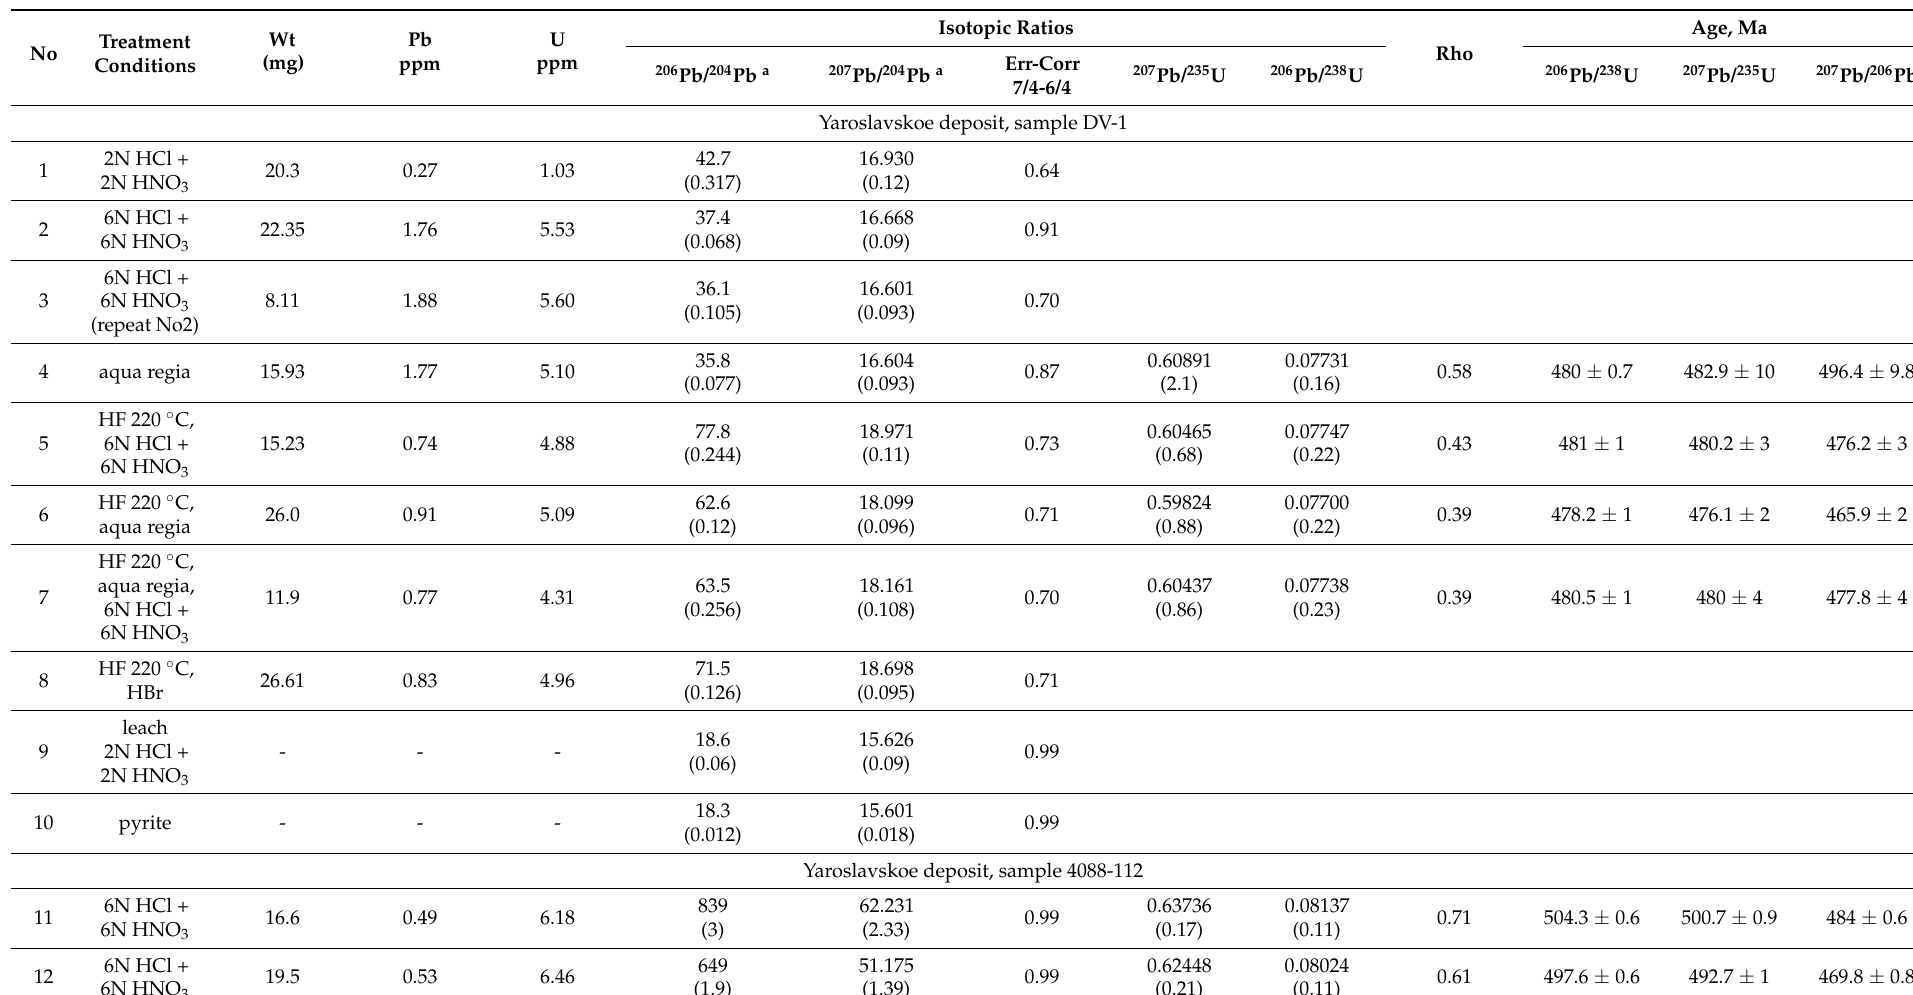
Table 5. U–Pb isotopic data of cassiterite for Yaroslavskoe and Chapaevskoe